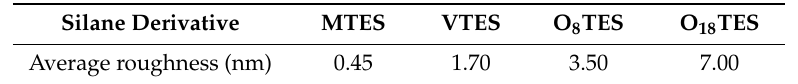
Table 1. Average roughness of the films obtained using only silica particles modifying agents.